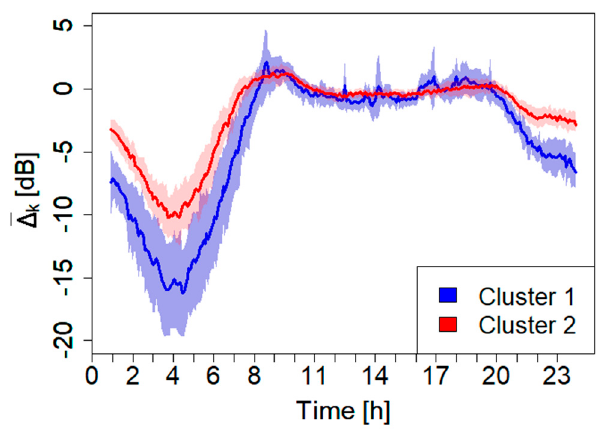
Figure 7. Mean normalized cluster profiles, ∆ k , and the corresponding error band, k indicates the cluster index. Time resolution τ = 5 min. The colored band represents the 1 σ confidence level. The normalized level used here is the same as the one determined in Figure 6. Table 1. Monitoring sensor information: code, group membership, non ‐ acoustic parameter, x = Log(T T ), and cluster membership according to the performed analysis (12 sensors belong to Cluster 1 and 12 to Cluster 2).